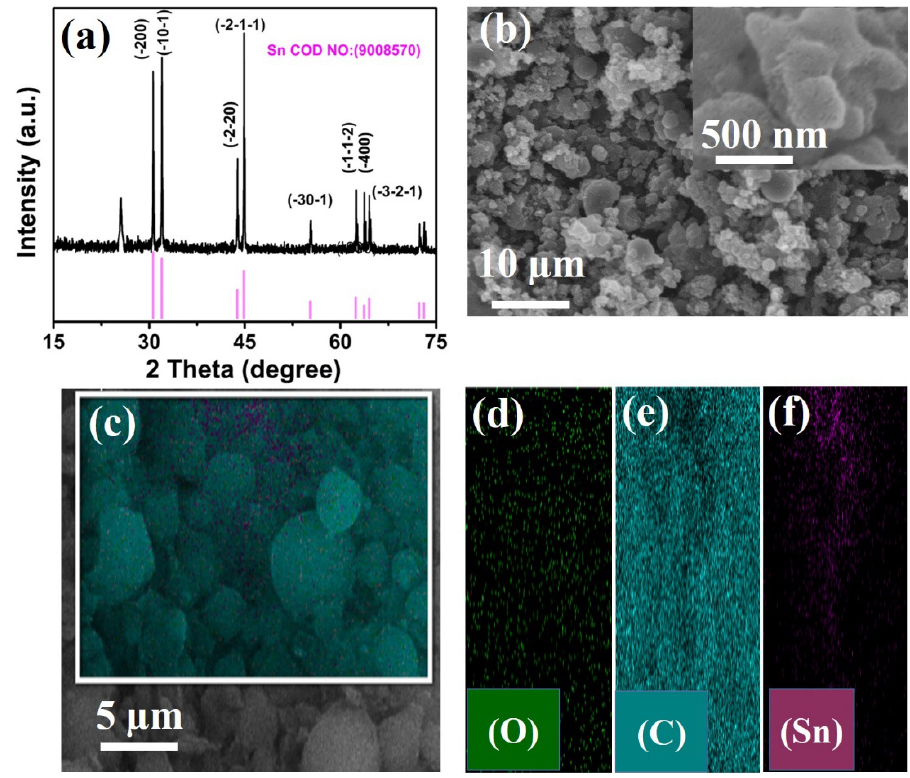
Figure 1. ( a ) XRD pattern of the Sn/C composite. ( b ) SEM images (low- and high-magnification images); ( c ) EDS and the corresponding elemental mapping ( d – f ) of the Sn/C composite.